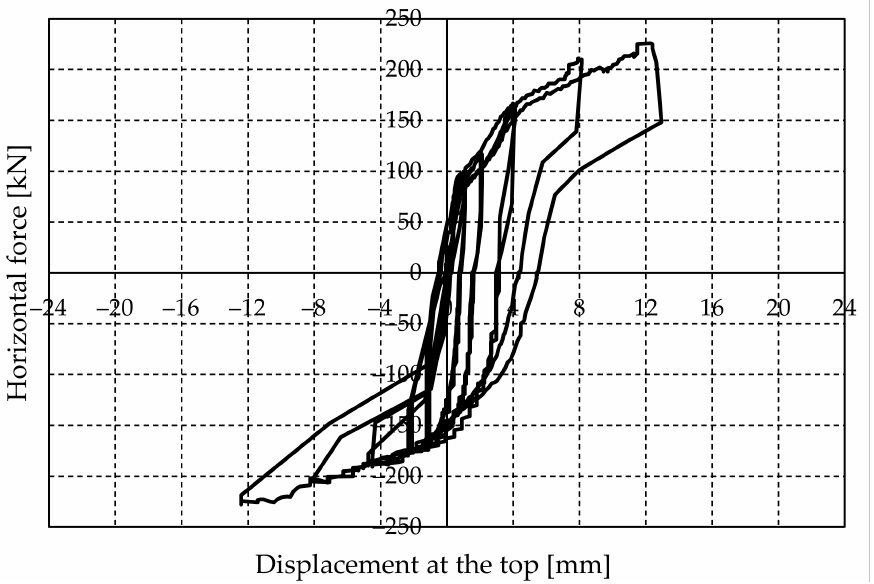
Figure 21. Force—displacement diagram for W4 (V = 460 kN, σ v = 0.8 N/mm 2 ).